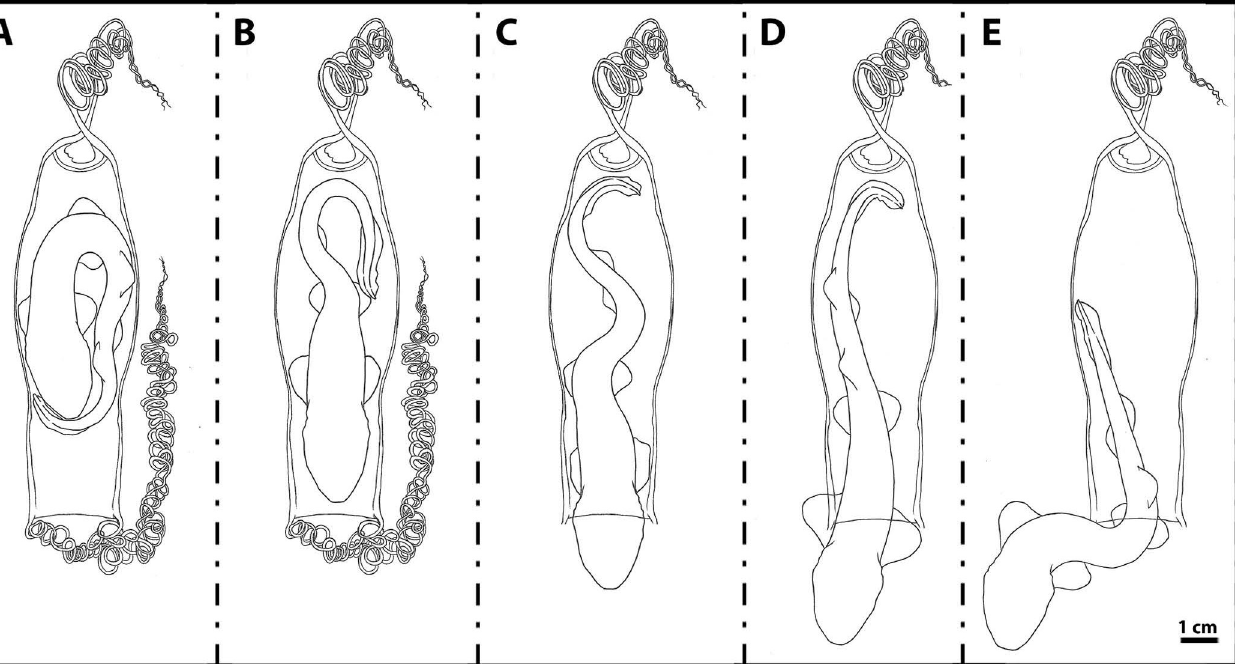
PLOS ONE | https://doi.org/10.1371/journal.pone.0206984 November6,